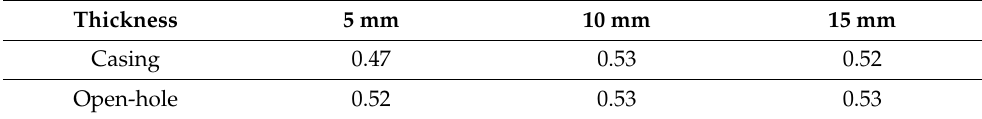
Table 3. Influence of different accumulation thickness of cuttings on friction coefficient.